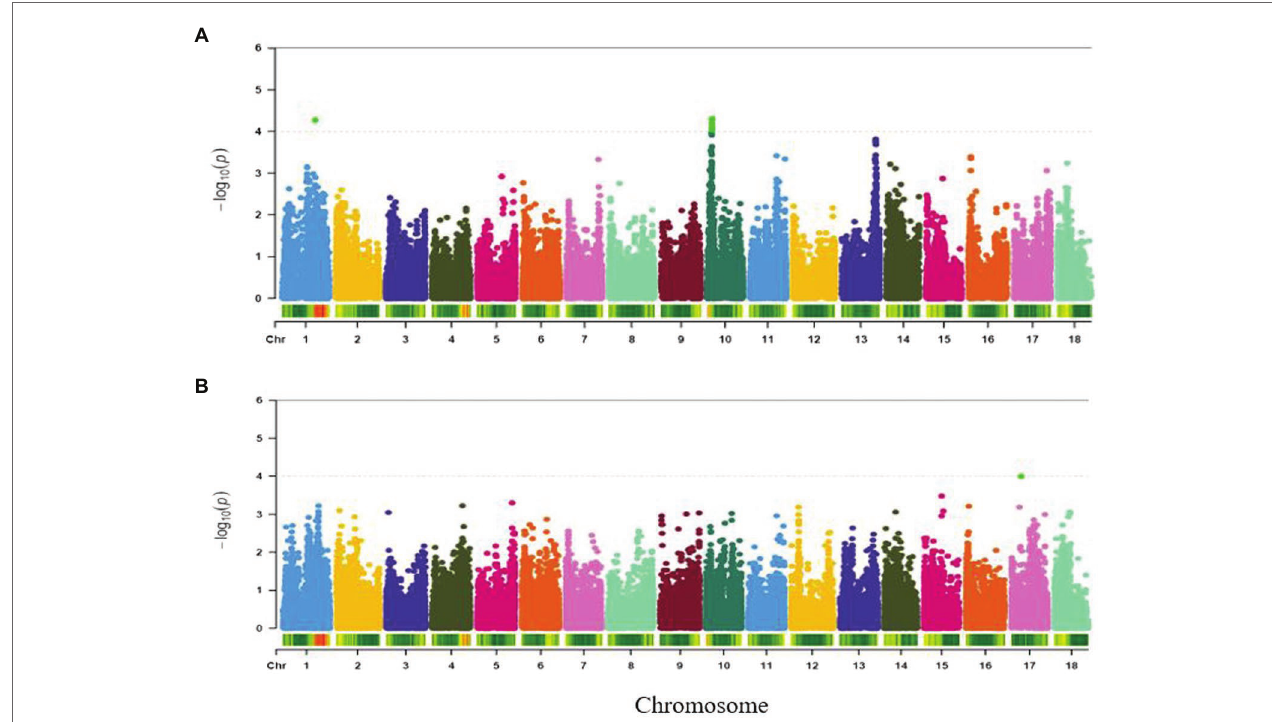
FIGURE 6 | Manhattan plots for GWAS based on best linear unbiased predictions for (A) root taste, and (B) aroma. The dashed horizontal line depicts the genome-wide significance threshold.